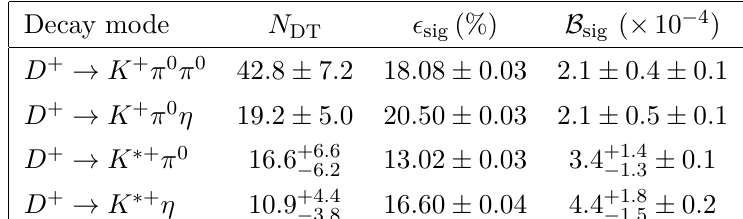
) and the obtained /(cid:15) i DT ST